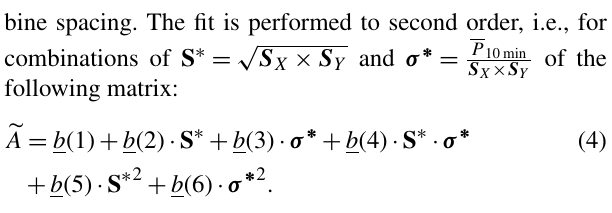
bine spacing. The fit is performed to second order, i.e.,